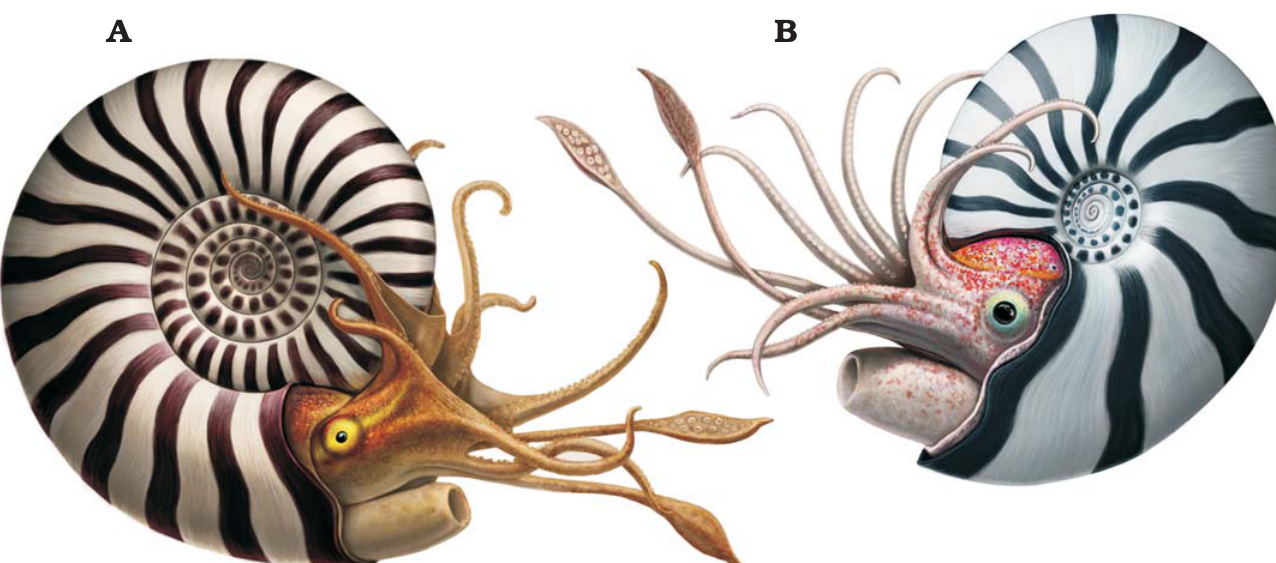
Fig. 14. Reconstruction of two Late Volgian ammonites from Craspeditidae family, Kachpurites fulgens (Trautschold, 1861) ( A ), Garniericeras catenu- latum (Fischer, 1830) ( B ). Ten arms are shown because Nautilus and representatives of Coleoidea exhibit five arm pairs in embryos, it can be a base number of arms in Cephalopoda (Kröger et al. 2011). Two long tentacles are very speculative. However, such tentacles for external-shelled cephalopods could be very useful for catching pray which is at a distance; since rapid jumping forward could be difficult for these mollusks. The large hyponome was shown because of the presence of a funnel-locking apparatus and hyponomic retractors, and also due to the shape of aperture edges with lateral apertural sinuses and the presence of a large round opening between lappets in some ammonites (Westermann 1990: fig. 2). The eyes were drawn similar to coleoid eyes because Ammonoidea and Coleoidea were sister taxons (Jacobs and Landman 1993). The dark transverse bands on the shells correspond to the most common ammonites’ color pattern (Keupp 2000). The presence of such a color pattern in the Craspeditidae family is confirmed by findings of shells with transverse dark bands (AAM unpublished material). This picture, drawn by Andrey Atuchin, was based on the sketch of the author of this